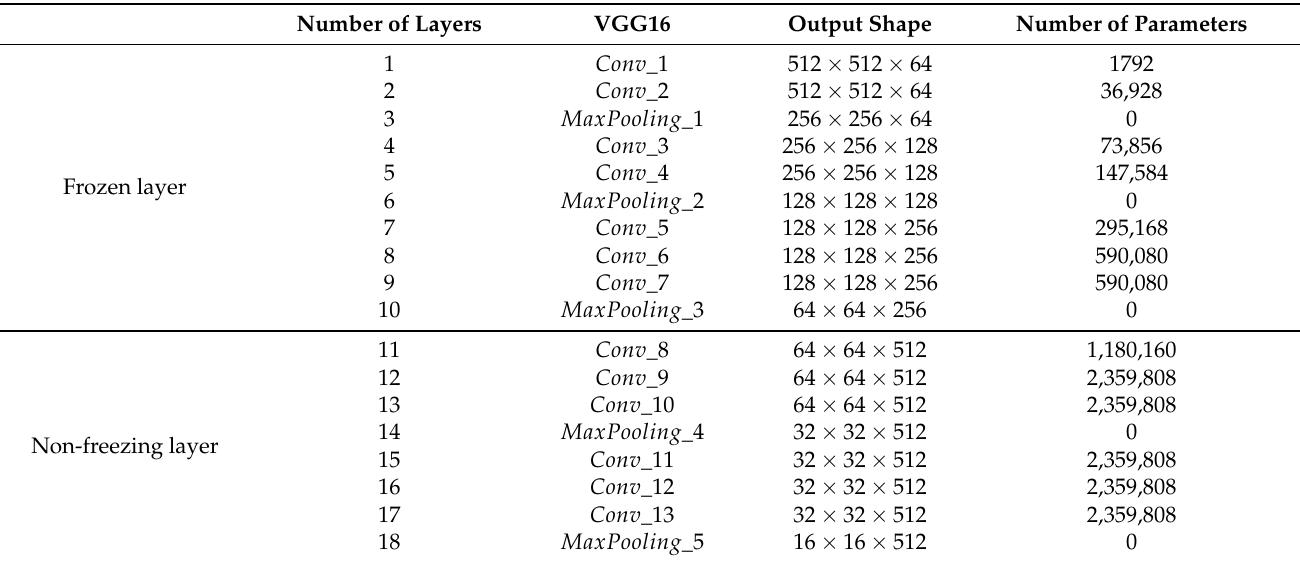
Table 2. The structure and parameters of the VGG16 transfer learning network of OplusVNet_10 with the input data size of 512 × 512 × 3.